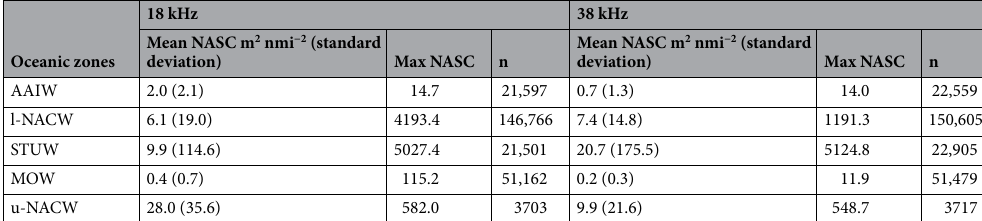
Table 3. Mean NASC values in the water column (from 15 to 1200 m) according to the oceanographic zones for different frequencies. AAIW = Antarctic Intermediate Water, l-NACW = lower North Atlantic Central Water, STUW = Subtropical underwater, MOW = Mediterranean Overflow Water and u-NACW = upper North Atlantic Central Water). N = sampling size of the NASC values, i.e., the number of integration cells (NASC in each 5 m depth and 600 s temporally) corresponding to each water